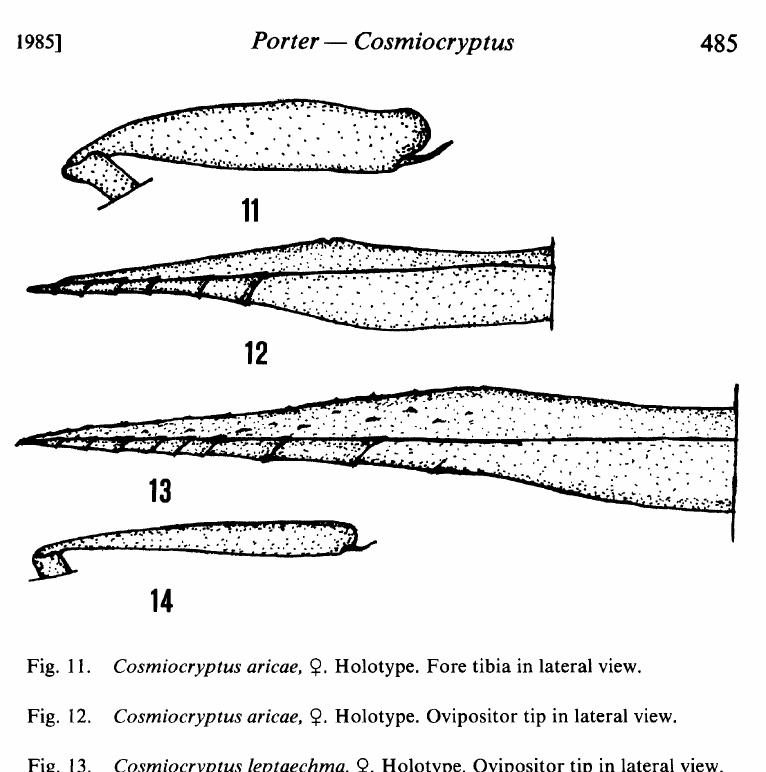
Fig. 11. Cosmiocryptus aricae, Fig. 12. Cosmiocryptus aricae, Fig. 13. Cosmiocryptus leptaechma, Fig. 14. Cosmiocryptus leptaechma,